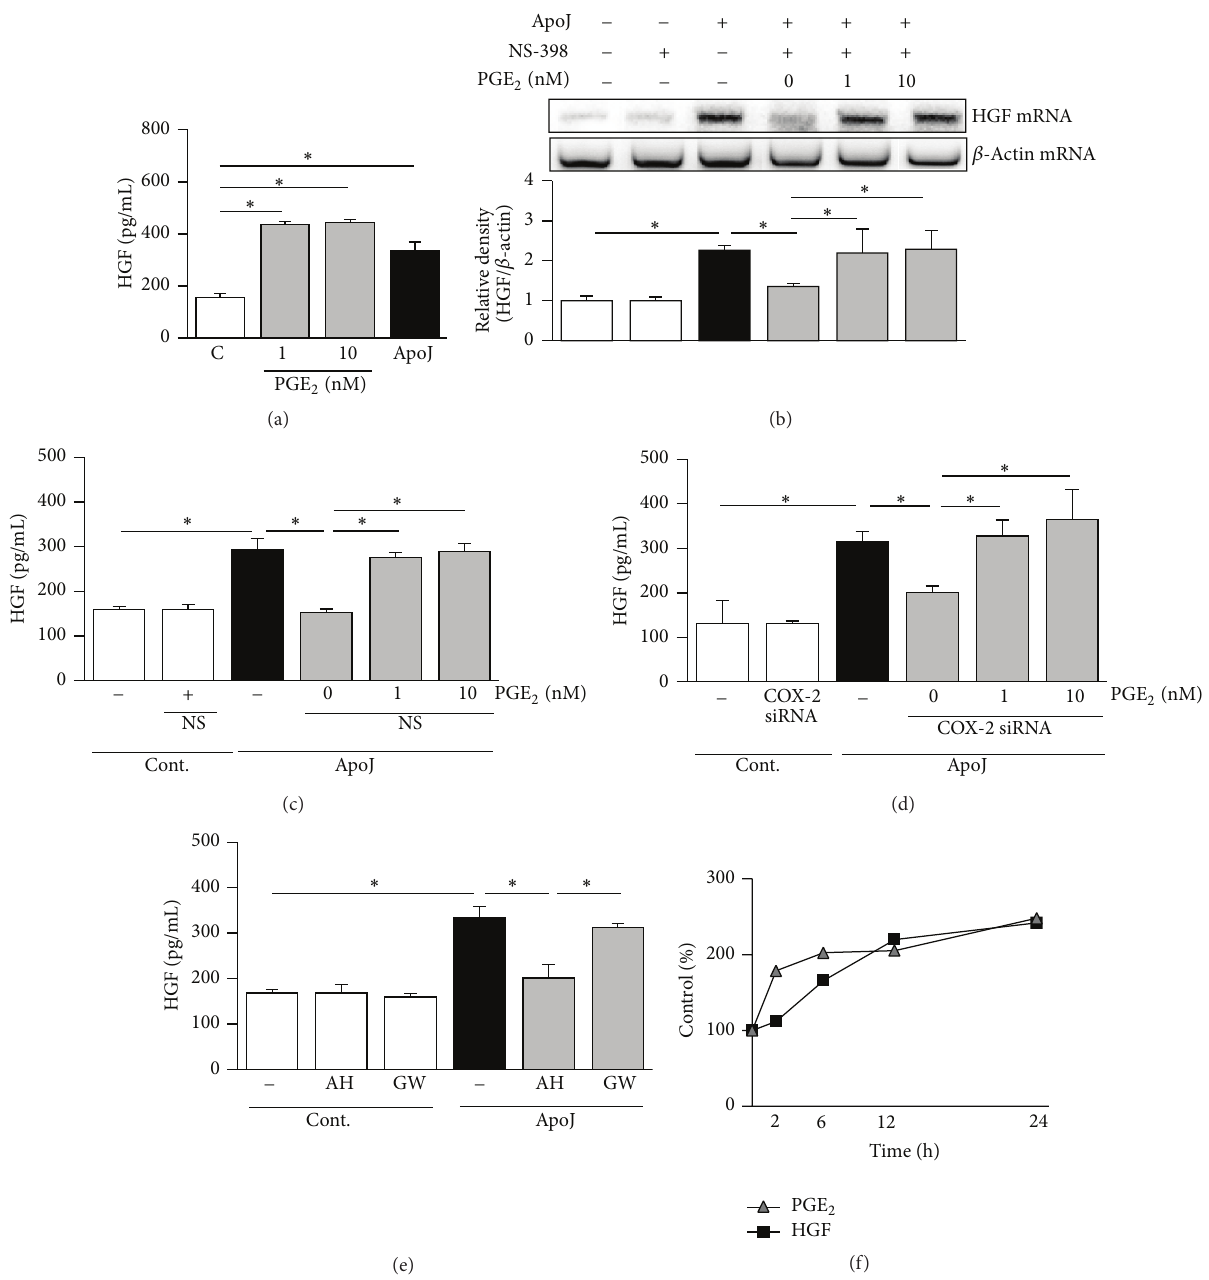
Figure 4: COX-2/PGE 2 signaling is required for HGF production in response to apoptotic cells. (a) RAW 264.7 cells were treated with 1 or 10nM of PGE 2 for 24 h to detect secreted HGF. (b, c) After 1h pretreatment of 10 𝜇 M NS-398, apoptotic Jurkat cells (ApoJ) with or without PGE 2 were added to RAW cells for 2h to detect HGF mRNA or for 24 h to detect secreted HGF. (d) Transfected RAW cells with siRNA against COX-2 were stimulated with ApoJ with or without 1 or 10nM PGE 2 for 24h. (e) Raw cells were pretreated with 10 𝜇 M of EP2 receptor antagonist, AH-6809 (AH), or 10 𝜇 M of EP4 receptor antagonist, GW 627368X (GW), for 1h and then stimulated with ApoJ for 24 h. (a, c–e) HGF levels in conditioned media were measured by ELISA. (b) HGF mRNA levels were analyzed by semiquantitative RT-PCR. Values represent mean ± SEM of three or more separate experiments; ∗ 𝑃 < 0.05 . (f) RAW cells were stimulated with ApoJ for a 24 h period and PGE 2 and HGF levels in the supernatants were measured at each time points by EIA and ELISA, respectively, and expressed as percent of control. Data are representative from separate three